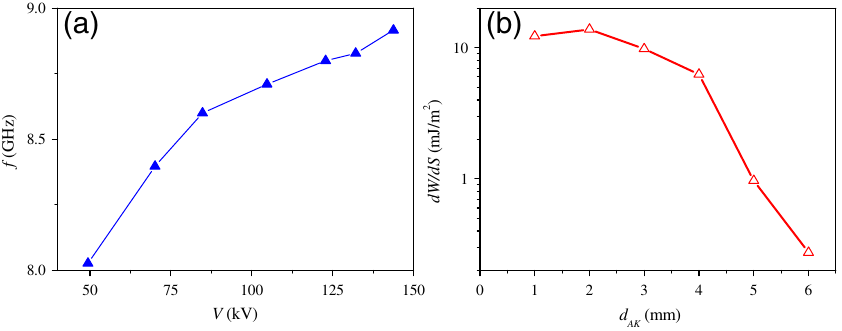
FIG. 4. (Color) (a) Second harmonic frequency vs peak voltage. (b) X-band horn energy/area vs d AK